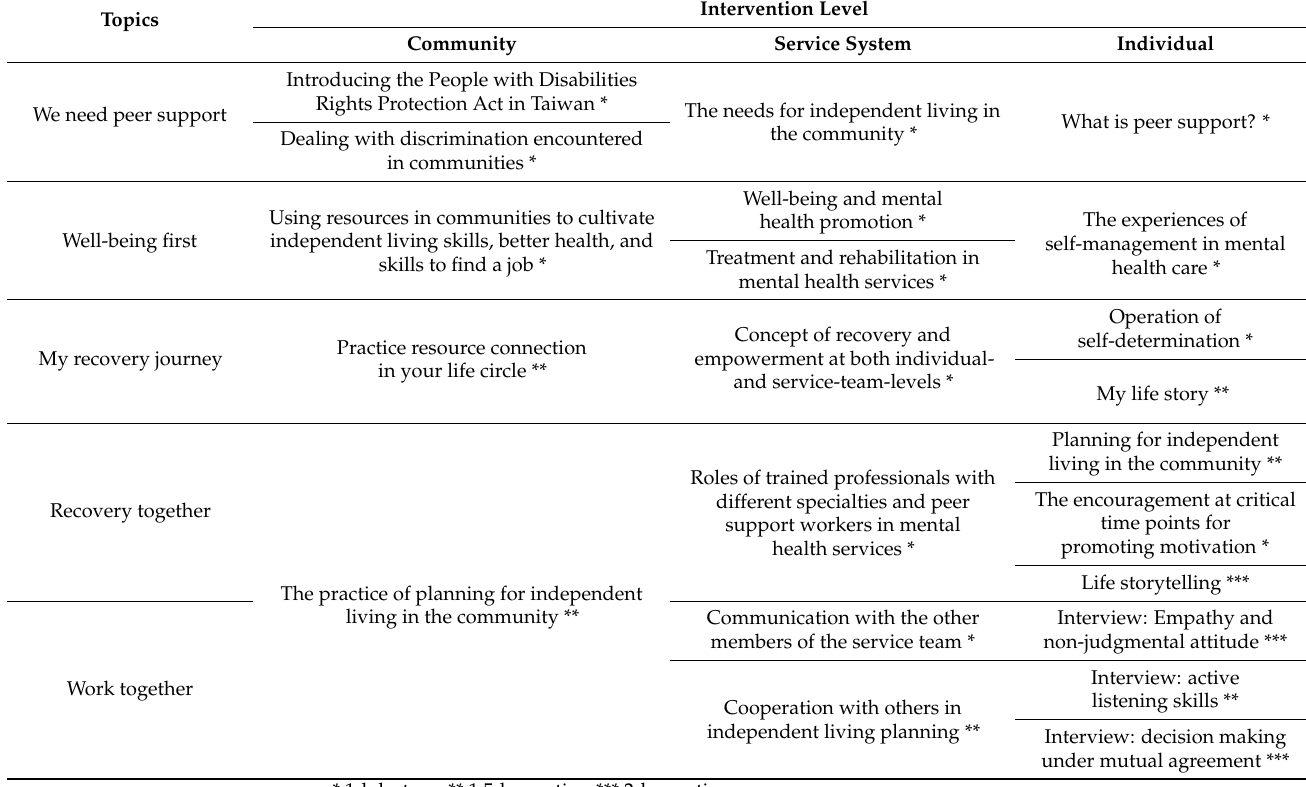
Table 1. The training course for trainees with severe mental